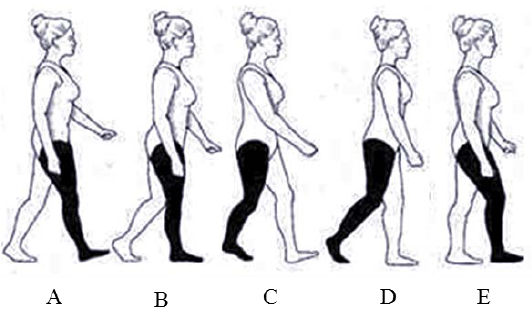
Figure 9. Diagram of gait conversion process. ( A ) Rear foot touch; ( B ) Entire foot touch; ( C ) Rear foot leave and forefoot touch; ( D ) Entire foot leave; ( E ) Foot strike.